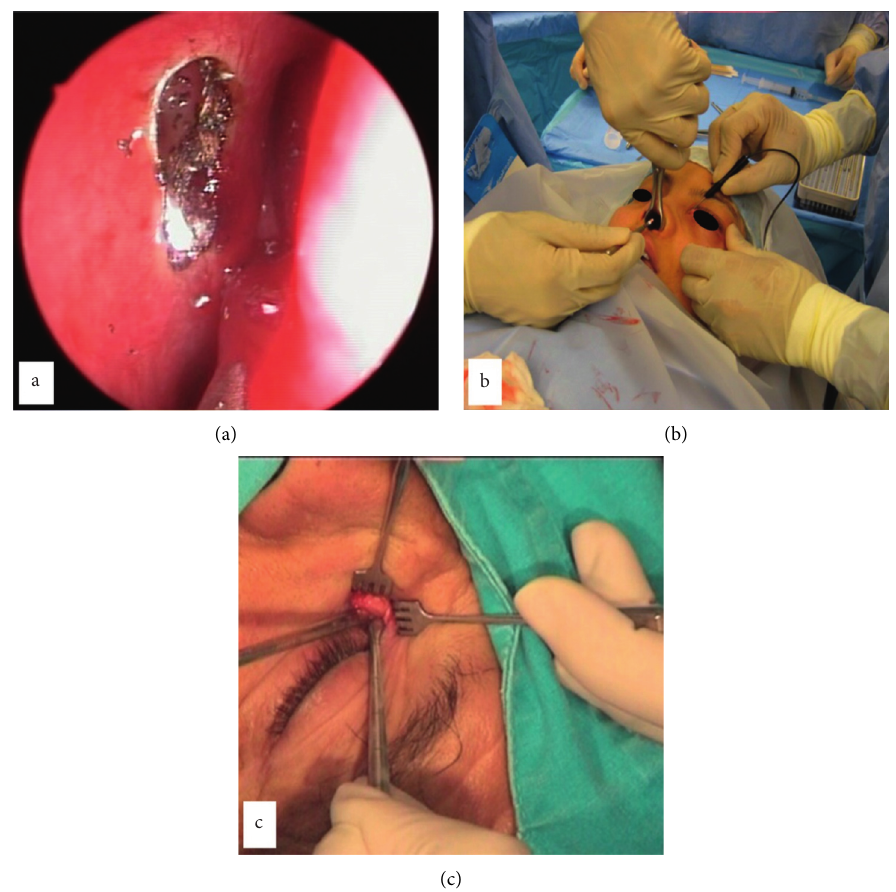
Figure 2: Intraoperative images from three different types of DCR surgeries: TCL-DCR (a), NEN-DCR (b), and EXT-DCR